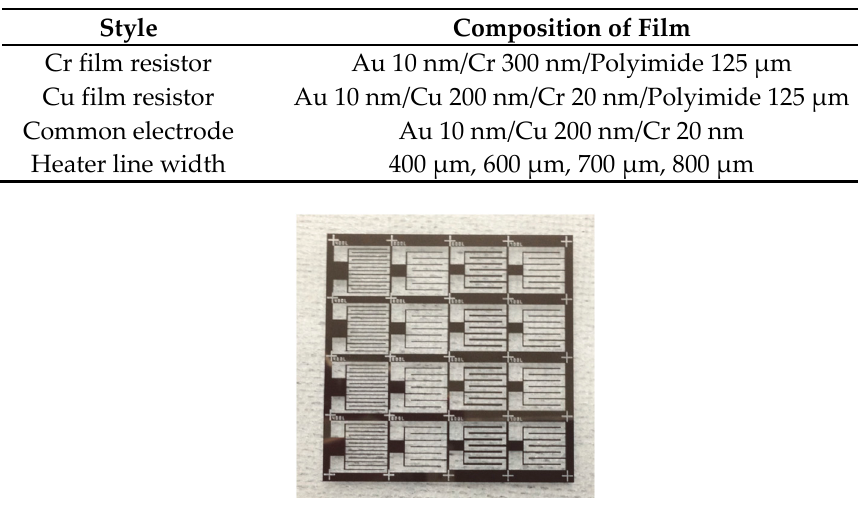
Figure 5. Glass mask of